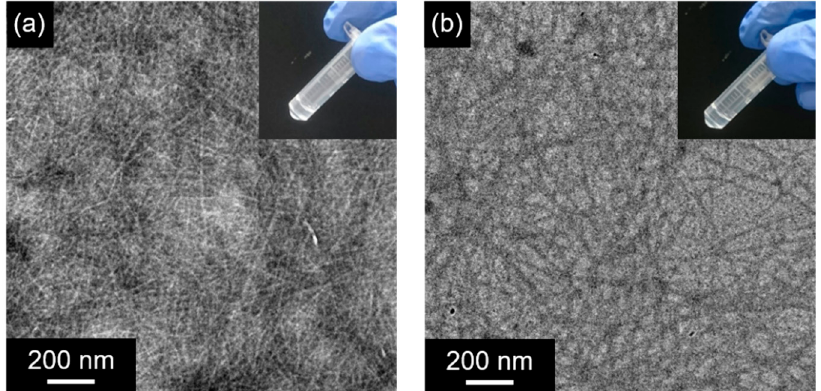
Figure 2. TEM images of the hydrogel of ( a ) 0.5 wt% GPG1, 1 d at 37 ° C, ( b ) 0.5 wt% of GPG3, 7 d at 37 ° C. Insets show photographs of the hydrogels.